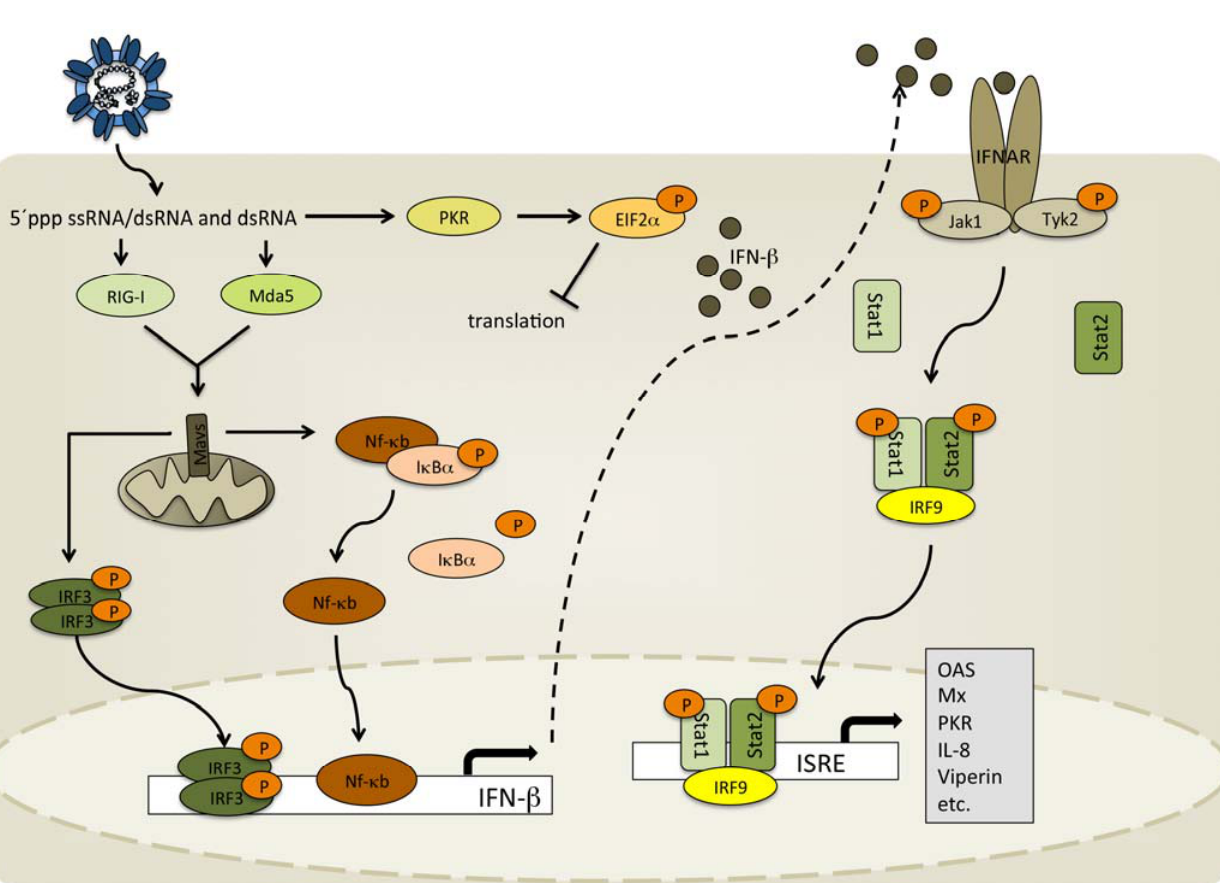
Figure 2. General activation of interferon- β (IFN- β ) transcription and induction of IFN-stimulated genes. Biochemical and structural features in the RNA genome or dsRNA produced through viral replication is recognized by RIG-I and Mda5 in the cytoplasm leading to the activation and translocation of IRF-3 and NF- κ B into the nucleus where they are involved in initiating the transcription of IFN- β . In addition, 5’-triphosphorylated dsRNA in nucleocapsids triggers the activation of RIG-I and its downstream signaling, as has been shown for Rift Valley fever virus (RVFV) and La Crosse virus (LACV) [45]. The resulting IFN- β is transported out of the cell where it binds to IFN receptors (IFNAR), thereby activating the JAK/STAT pathway leading to the transcription of a number of different IFN stimulated genes that aim to restrict viral replication and spread and initiate an antiviral state in uninfected